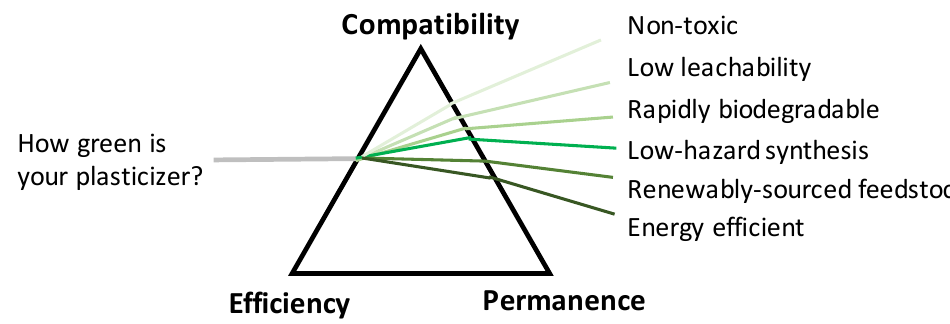
Figure 1. Green plasticizer design considerations. Adapted from R.F. Boyer, 1951 [22].